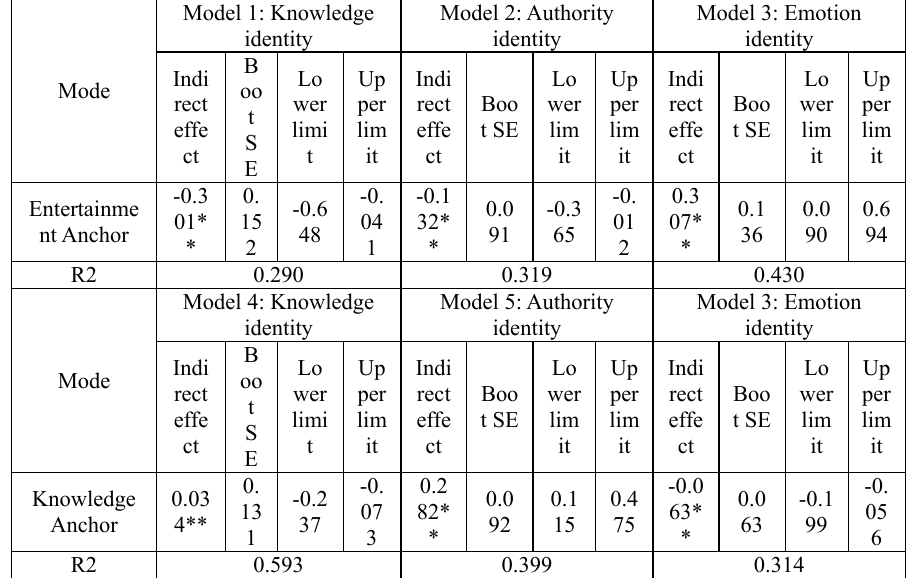
Table 4. The mediating role of user